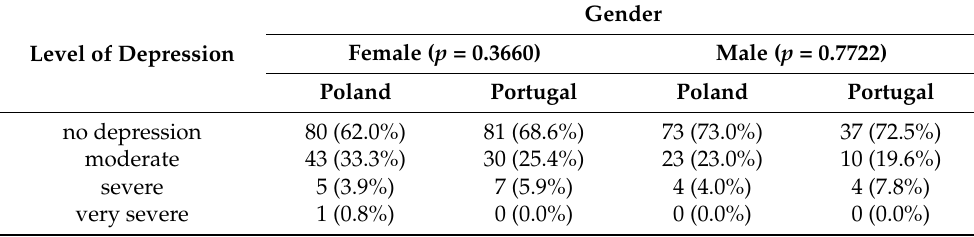
Table 3. Level of depression severity in Poland and Portugal according to gender on a four-point